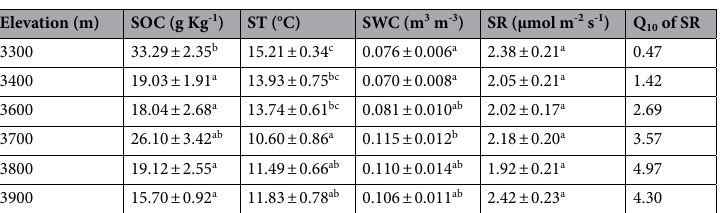
Table 1. Comparison of the environmental parameter at different elevations. Growing season mean soil temperature (ST), volumetric soil water content (SWC), SR and Q 10 of SR at different elevations. Values are mean ± standard error of mean with n = 48. Different letters indicate a significant difference in each parameter between elevations (p < 0.05).